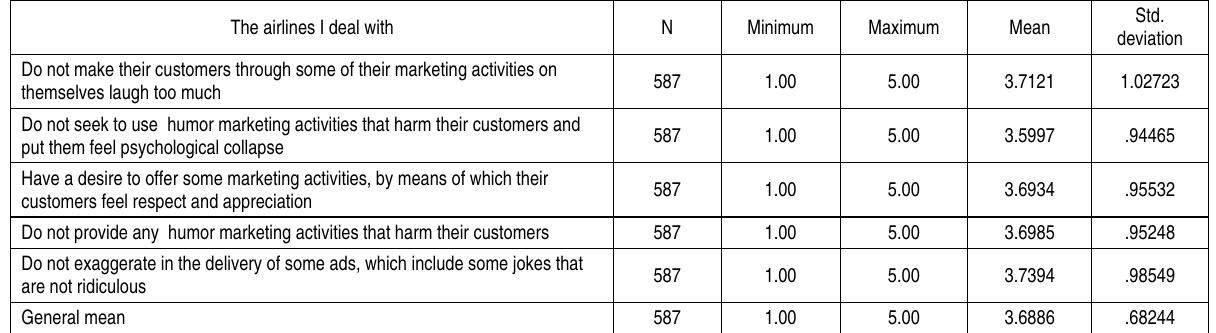
Table 7. Means and standard deviations of sample’s responses regarding the self-defeating humor variable